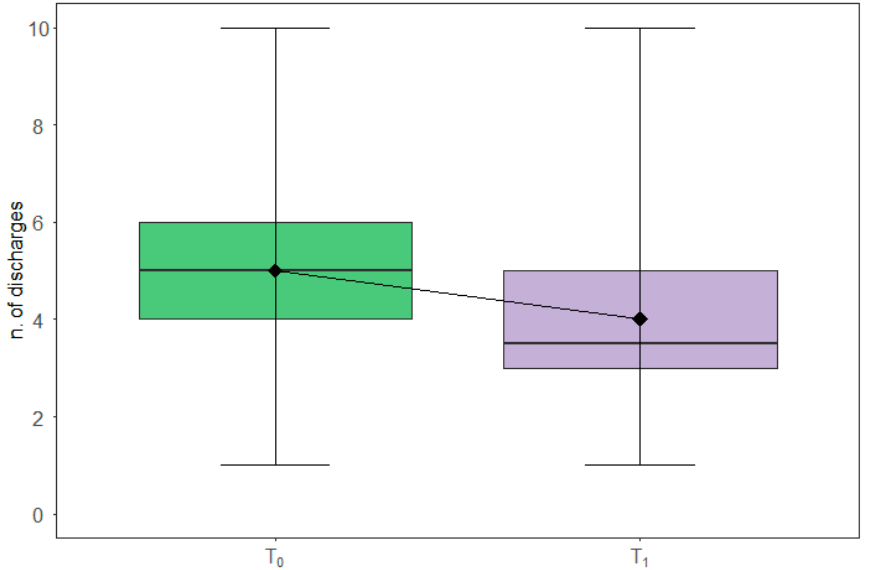
Figure 3. Diarrheal discharges modulation. The box plots report the overall distribution of diarrheal discharges at T0 and T1. Each box indicates the 25th and 75th centiles. The horizontal line inside the box indicates the median; the black diamond represents the mean; the whiskers indicate the range measure.